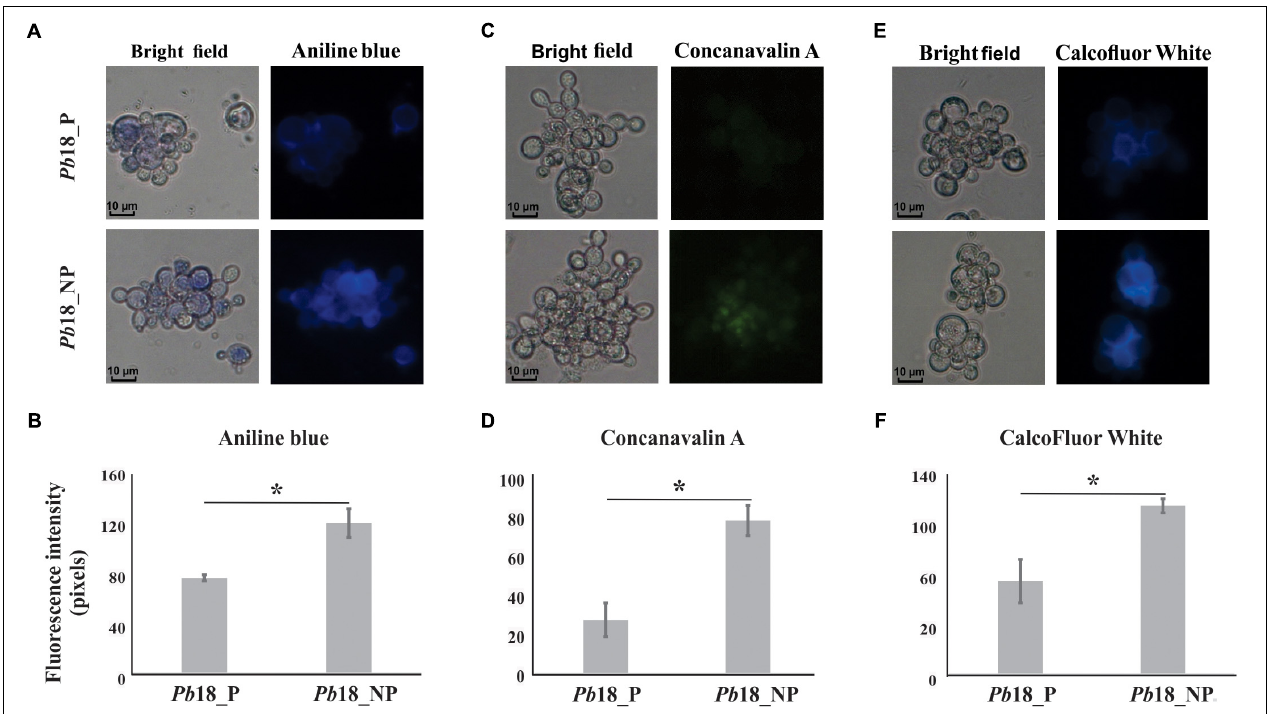
FIGURE 5 | Evaluation of cell wall components of P. brasiliensis Pb 18 recovered from alveolar macrophages. The yeast cells recovered of macrophages were incubated with (A) aniline blue to evaluate the contents of glucans; (C) ConA Type VI conjugated to FITC to evaluate glycosylated proteins and (E) CFW to evaluate chitin amount in the cell wall. (B, D, F) Fluorescence intensity graph. The values of fluorescence intensity (in pixels) and the standard error of each analysis were used to plot the graph. Data are expressed as mean ± standard error (represented using error bars). ∗ Significantly different comparison between treated cells in a P -value of ≤ 0.05. All representative images were magnified 400 ×